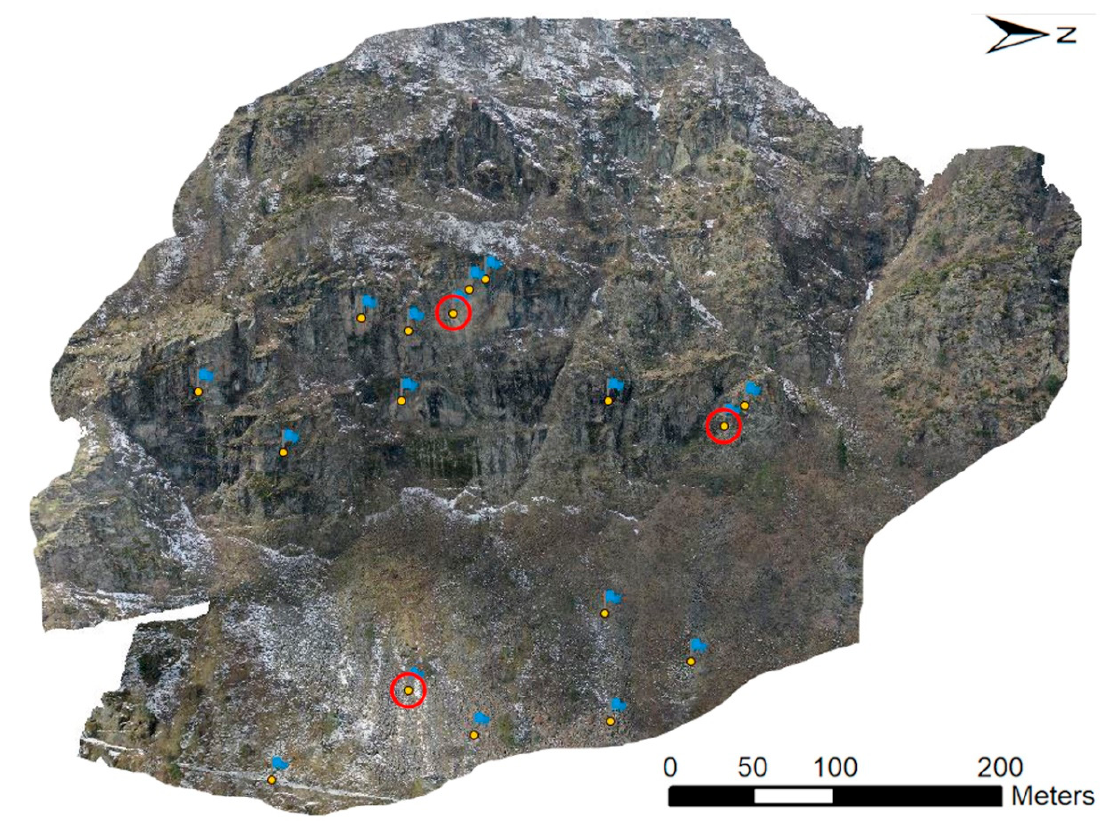
Figure 6. Prospective view of the georeferenced 3D point cloud; the blue flags localize GCPs and CPs on the slopes; CPs are highlighted by a red circle.